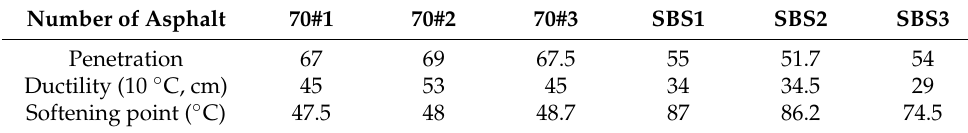
Table 4. Three indexes of different